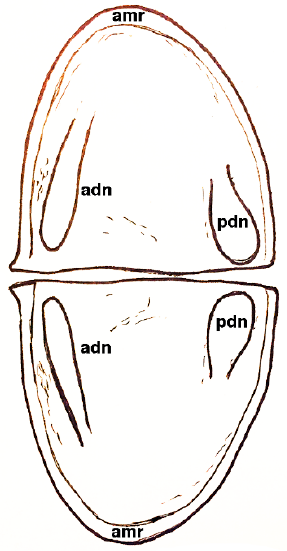
Figure 4. Albrunnicola bengtsoni . Paired shields shown in butterfly position. Anterior to left. Length of shield 1.5 mm. Abbreviations: adn , anterodorsal node; amr , admarginal rim; pdn , posterodorsal node. Image Credit: Mark McMenamin.